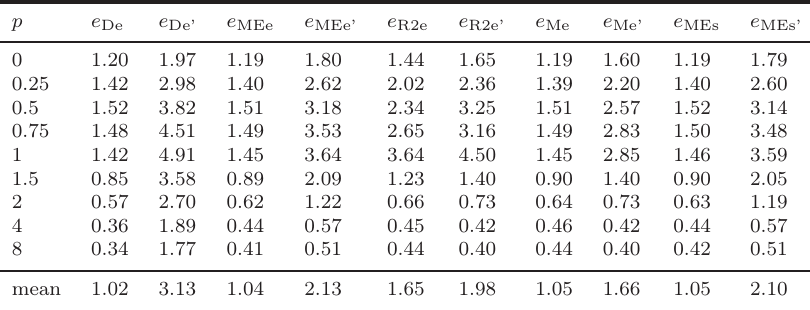
Table 4. Means of error ratios for extrapolated approximations, n = 3